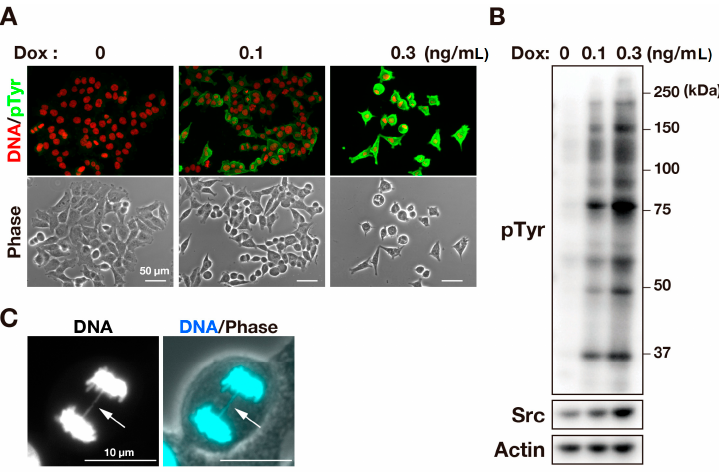
Figure 1. v-Src induces chromosome bridge formation. HCT116/v-Src cells were cultured with Dox at the indicated concentrations for three days. ( A ) The cells were fixed with PBS containing 4% formaldehyde for 20 min at room temperature and stained for pTyr (green) and DNA (red); ( B ) Whole cell lysates were subjected to a Western blot analysis. Blots were probed with anti-phosphotyrosine (pTyr), anti-Src (GD11), and anti-actin (loading control) antibodies; ( C ) The cells were fixed and stained for DNA (cyan). The arrow indicates a chromosome bridge.